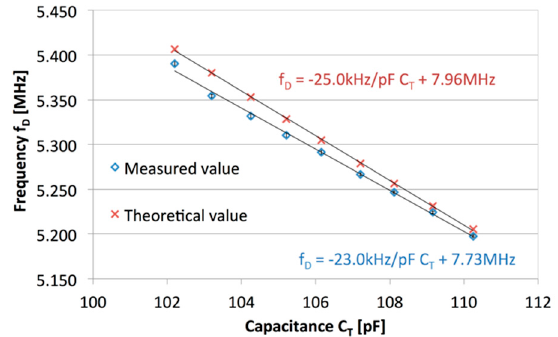
Figure 4. Measured and theoretical values of the damped frequency f D as a function of the total capacitance C T .